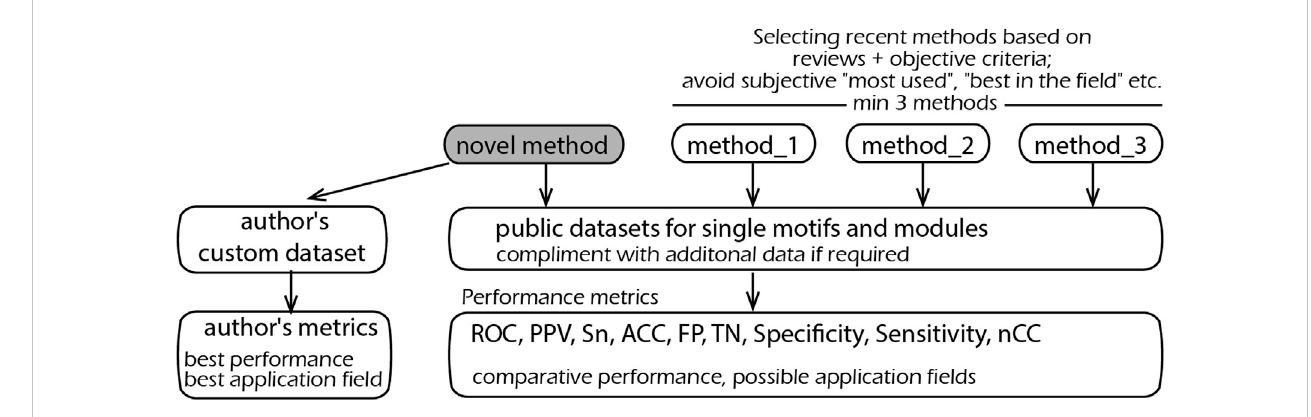
FIGURE 1 Schematic representation of the proposed principles on the selection of methods, metrics, and datasets for comparative